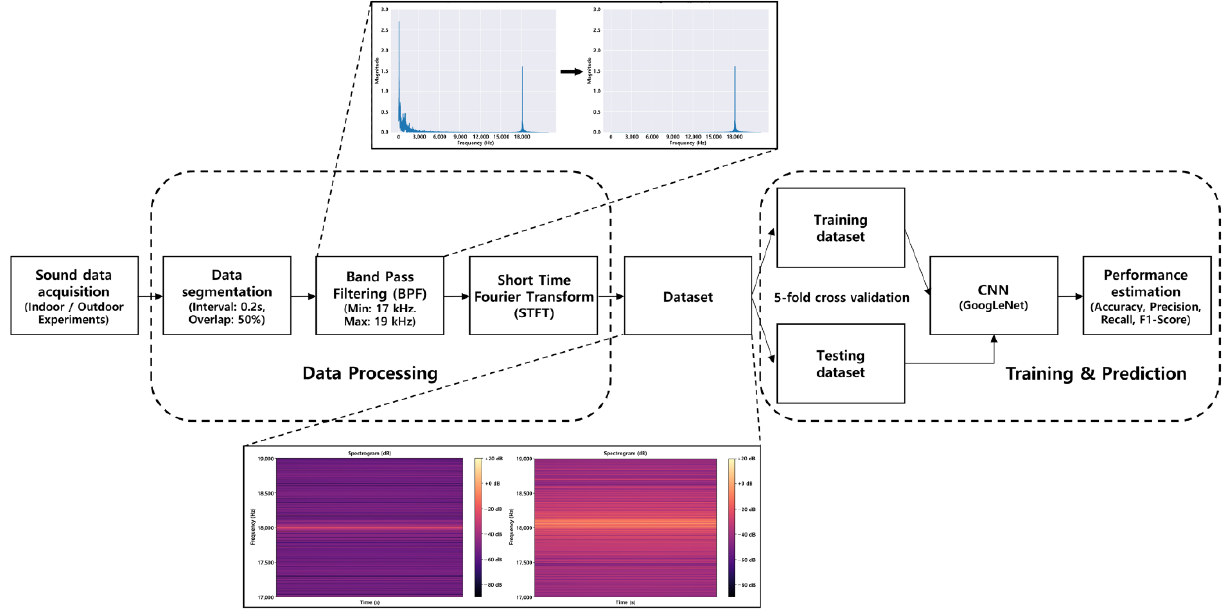
Figure 1. Flowchart of Proposed Movement Monitoring System.